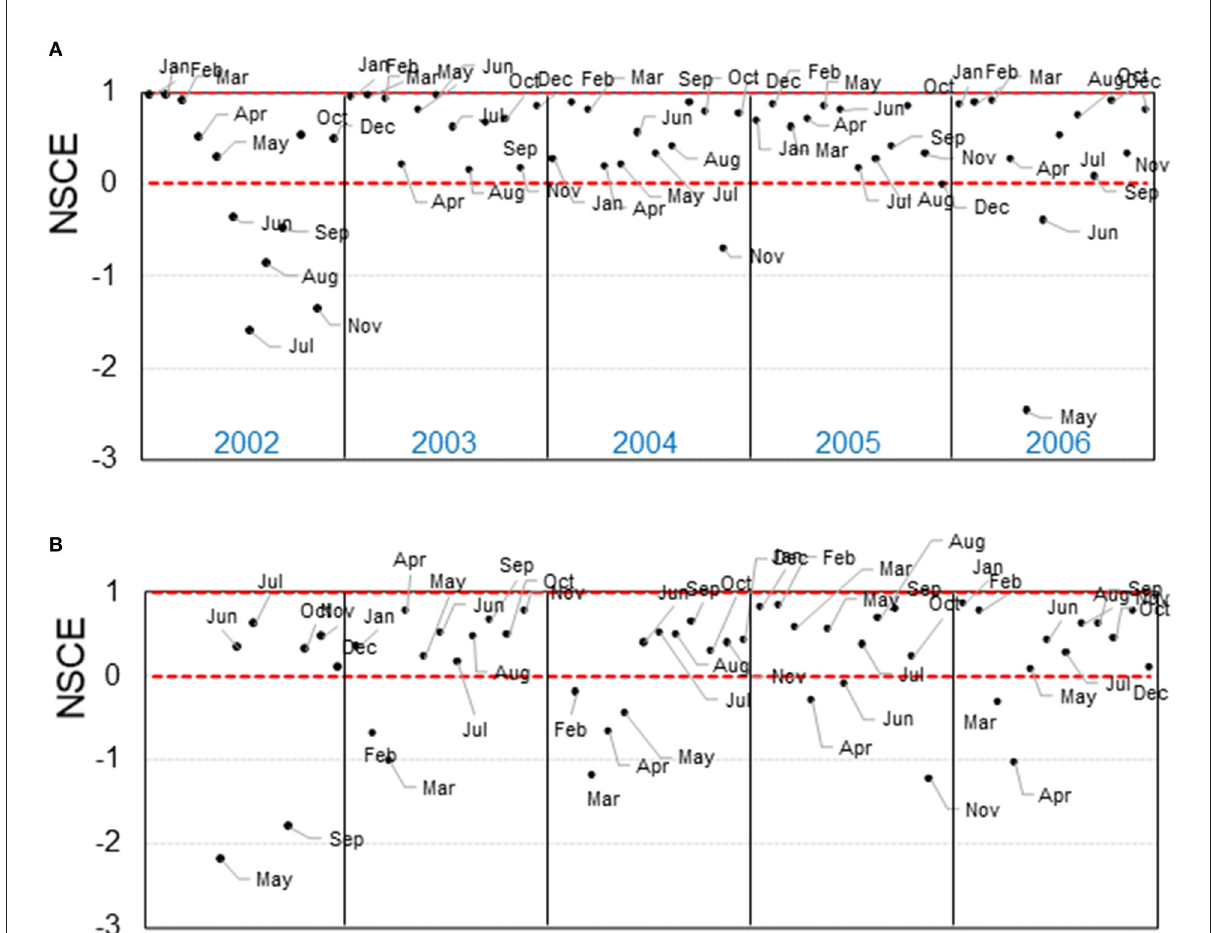
spike simulated concentration shown in Figure 8A